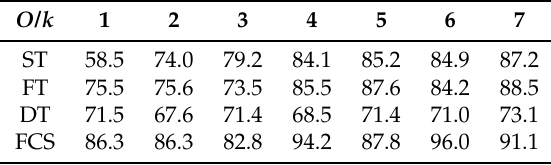
Figure 3. The SAR test performance versus the number of labeled data per class. ST, Supervised Training; FT, Fine-Tuning; DT, Direct Transfer. Table 1. Comparison results for the SAR test